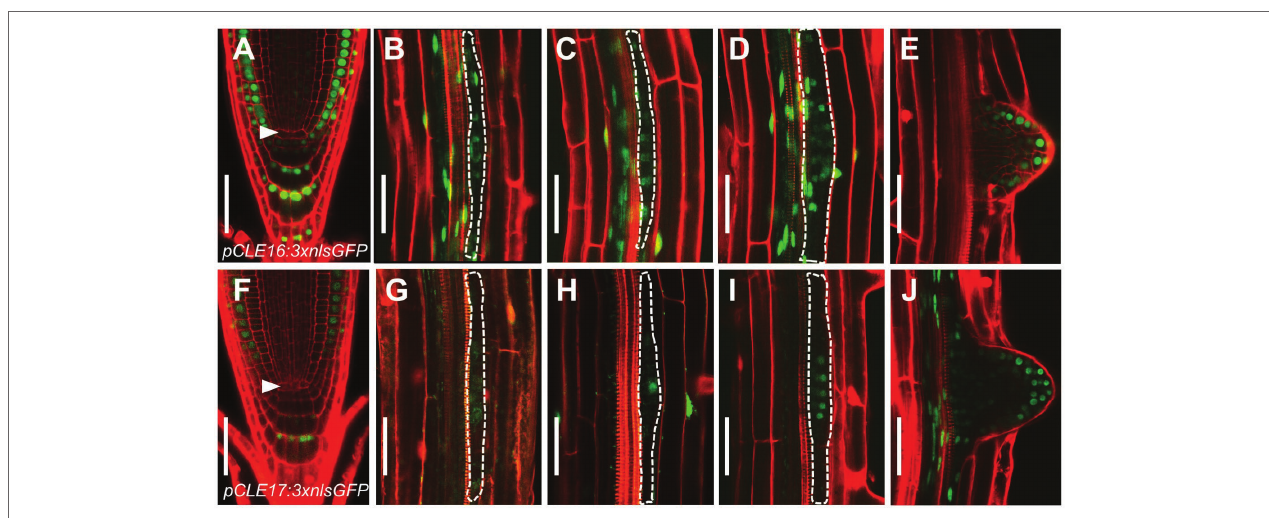
FIGURE 1 | CLAVATA3/EMBRYO SURROUNDING REGION-RELATED ( CLE ) promoter activity in roots. (A–J) Representative expression patterns of CLE16 (A–E) and CLE17 (F–J) in primary root tips at 5 days post-germination (dpg; (A,F) early lateral root primordia (LRP) at stage I–III (B–D,G–I) and emerged lateral roots (E,J) . GFP, green; propidium iodide, red. Arrowheads indicate the quiescent center (QC) cells (A,F) . LRPs are outlined with dotted lines (B–D,G–I) . Scale bars represent 50 μ